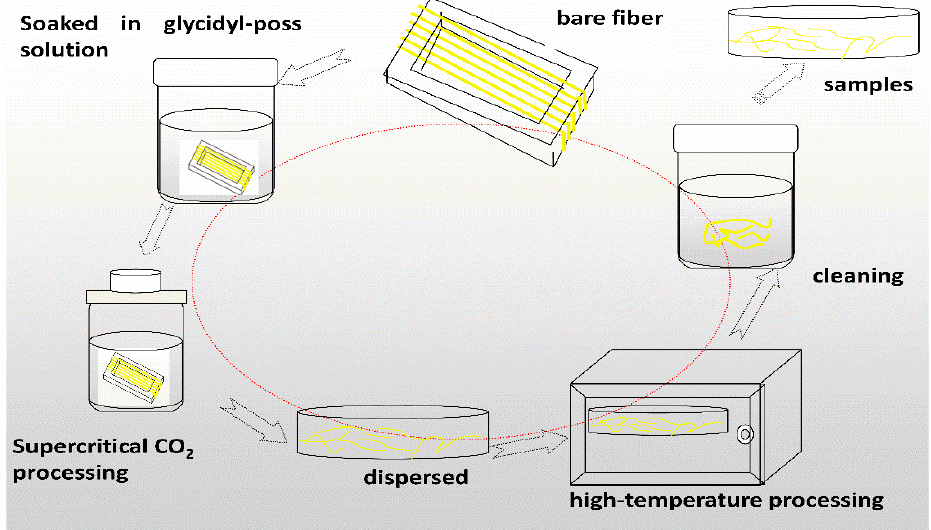
Figure 2. Diagram of glycidyl-polyhedral oliomeric silsesquioxane (POSS) grafting on aramid fibers (AF) preparation process.